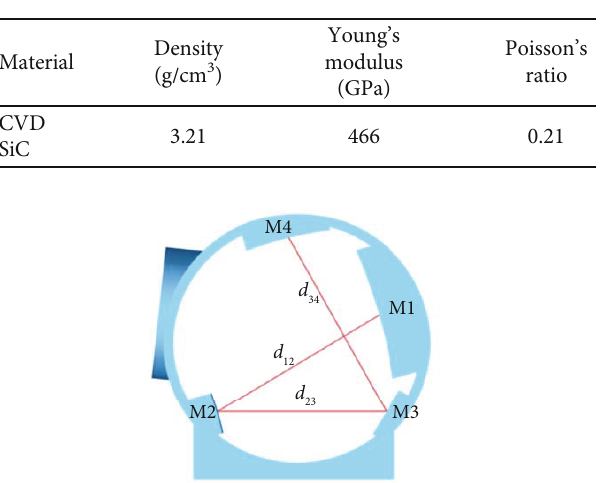
Figure 1: Coordinate system. Table 1: Material properties of the multiplanar conformal o ff -axis four-mirror.